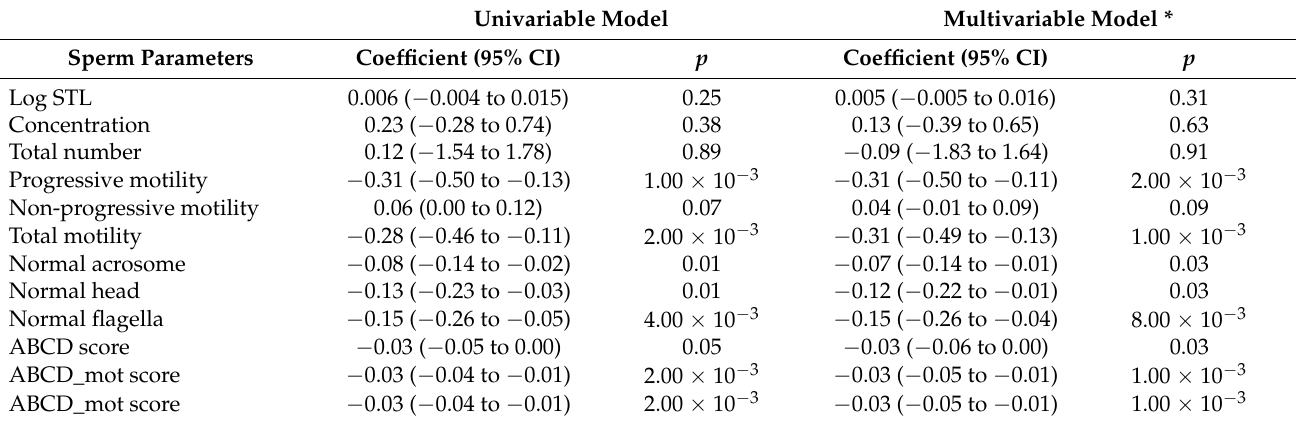
Table 2. Associations between age and sperm